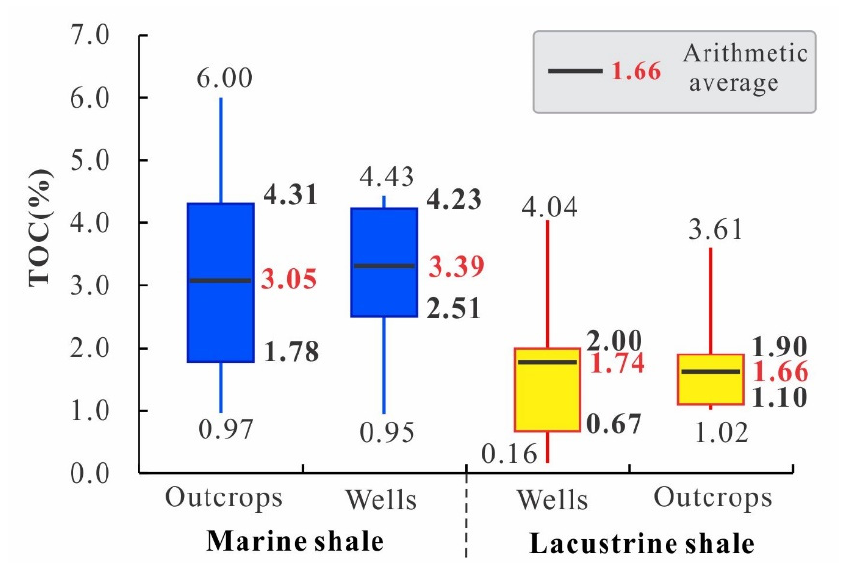
Figure 2. The TOC content of the marine and lacustrine shale samples from the wells and